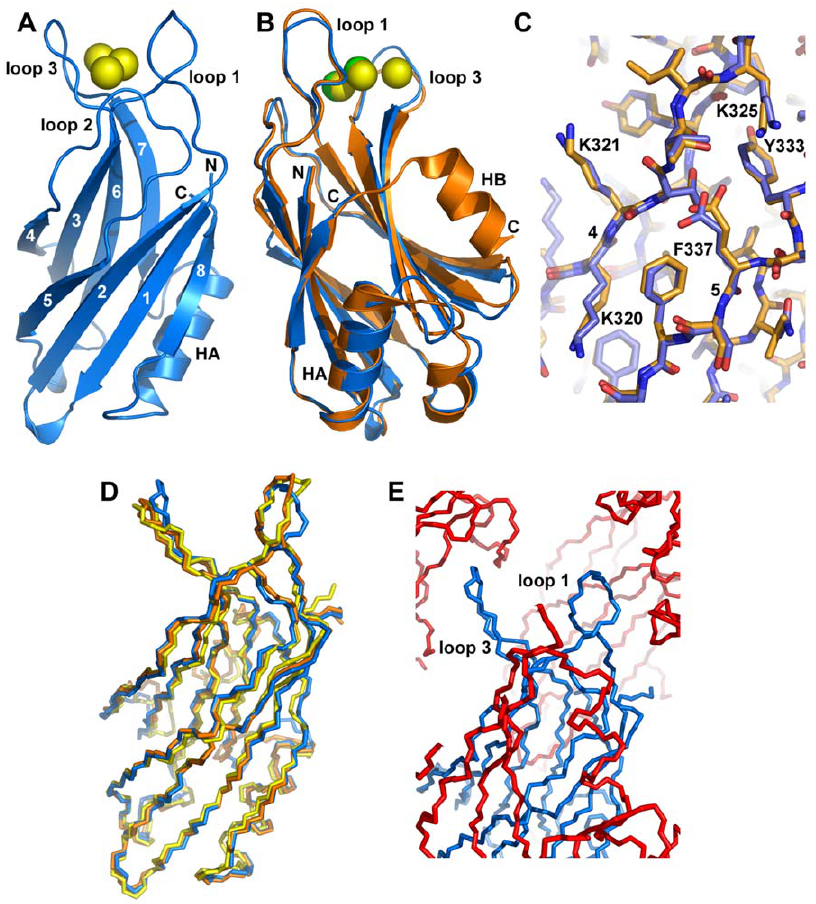
Figure 4. Crystal structure of the synaptotagmin-7 C 2 B domain. (A) Ribbon diagram of the crystal structure of the synaptotagmin-7 C 2 B domain with the b -strands numbered from 1 to 8. The positions of helix HA and the Ca 2 + -binding loops are indicated. Bound Ca 2 + ions are shown as yellow spheres. The N- and C-termini are labeled. (B) Superposition of ribbon diagrams of the crystal structures of synaptotagmin-7 C 2 B domain (blue) and the synaptotagmin-1 C 2 B domain [43] (PDB accession code 1UOW) (orange). The positions of a -helices HA and HB are indicated. (C) Stick models of the same superposition shown in panel (B) focusing on a region containing b -strands 4 and 5 (labeled with the corresponding numbers). Carbon atoms are colored in blue or orange for the C 2 B domains of synaptotagmin-7 and -1, respectively. Oxygen atoms are red and nitrogen atoms are blue in both structures. Selected side chains from the synaptotagmin-7 C 2 B domain are labeled. (D) Superposition of backbone stick models of the crystal structure of the synaptotagmin-7 C 2 B domain (blue), and the structures of the synaptotagmin-1 C 2 B domain determined by X-ray crystallography [43] (orange) or NMR spectroscopy [17] (PDB accession code 1K5W) (yellow). (E) Backbone stick models illustrating the extensive crystal contacts involving the Ca 2 + -binding loops of the synaptotagmin-7 C 2 B domain. The central molecule is colored in blue, with the positions of loops 1 and 3 indicated. Symmetry-related molecules within the crystal that contact the Ca 2 + -binding loops of this molecule are shown in red. The observed contacts are a result of crystal packing.